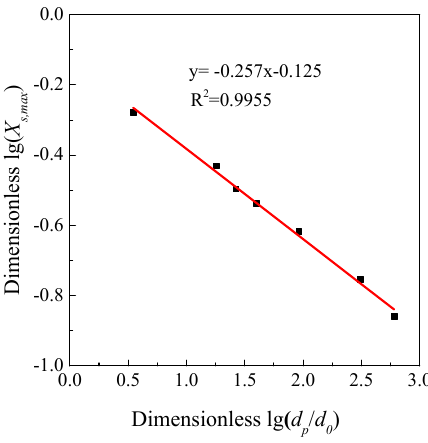
Figure 13. The relationship between apparent reaction rate constant ( K c ) and particle diameter ( d p ) of Shengzhou limestone.